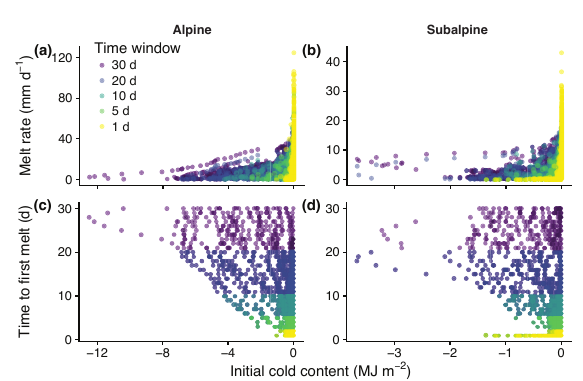
Figure 11. Simulated sub-seasonal snowmelt rate plotted against initial cold content in the alpine (a) and subalpine (b) , and time to first melt plotted against initial cold content in the alpine (c) and subalpine (d) for time windows from 1 to 30 days.